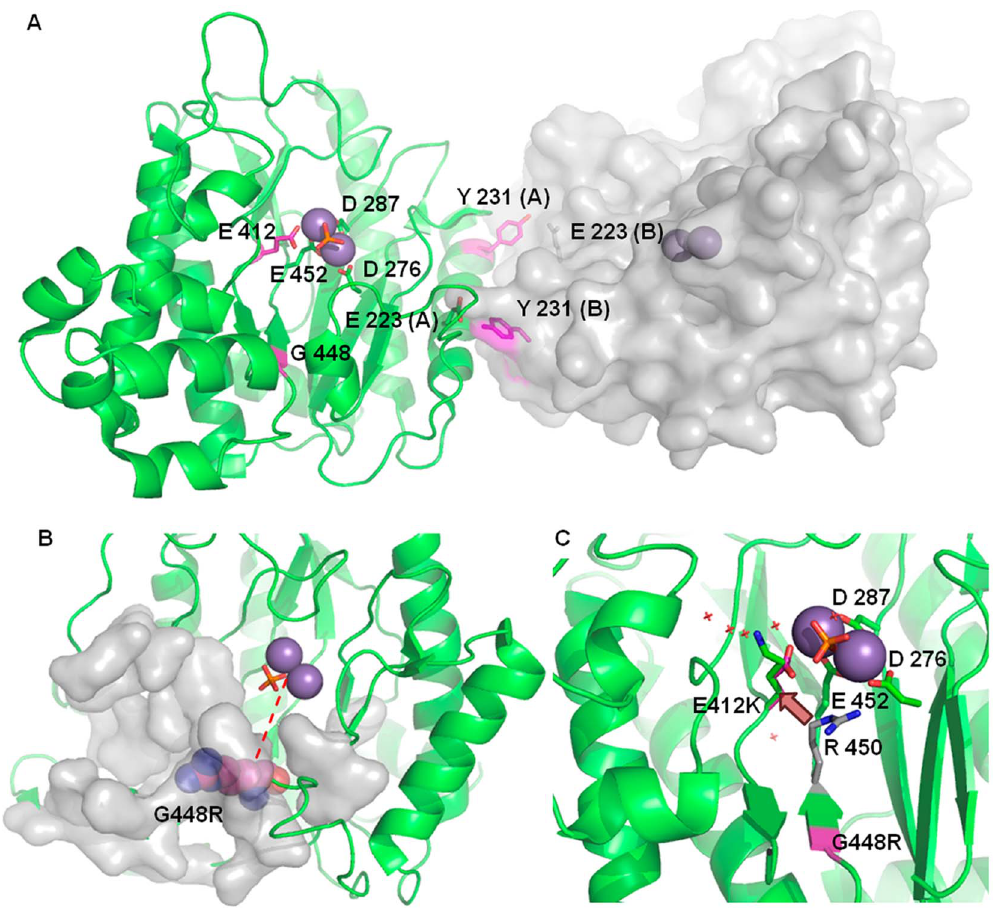
Figure 5. Mutant prolidase forms insilico modeling. (A) Human prolidase dimer: the two prolidase interfacing monomers are reported as a green cartoon (molecule A) and as a grey surface (molecule B), with Mn(II) shown as dark grey spheres. The magenta color was chosen to identify mutated residues. On molecule A, Mn(II) coordinating residues (D276, D287, E412 and E452) and the phosphate group (orange) are highlighted as sticks. Y231 residues from molecules A and B are located on the C-terminal portion of two a -helices arranged in a symmetric and anti-parallel manner, allowing their interaction with E223 of the interfacing protomer. (B) Destabilization of prolidase core structural elements upon G448R mutation. R448 substituenting residue is reported in spheres to highlight its steric hindrance. The protein portion that buries the mutated residue is shown as a grey surface. A red dashed line indicates the distance between the average position of Mn(II) ions and the C a of the substituted residue. (C) E412K substitution does not impair ions binding. Solvent molecules occupy a small cavity near the active site, and are represented with red crosses. This small cavity can host the side chain of the mutated K412 (reported in sticks with green carbon atoms and the nitrogen atom in blue) which substitutes E412 (magenta carbon and red oxygen atoms). The putative location of the K412 side chain here proposed may be set by the electrostatic repulsion exerted by residue R450 (shown in sticks with grey carbon atoms).